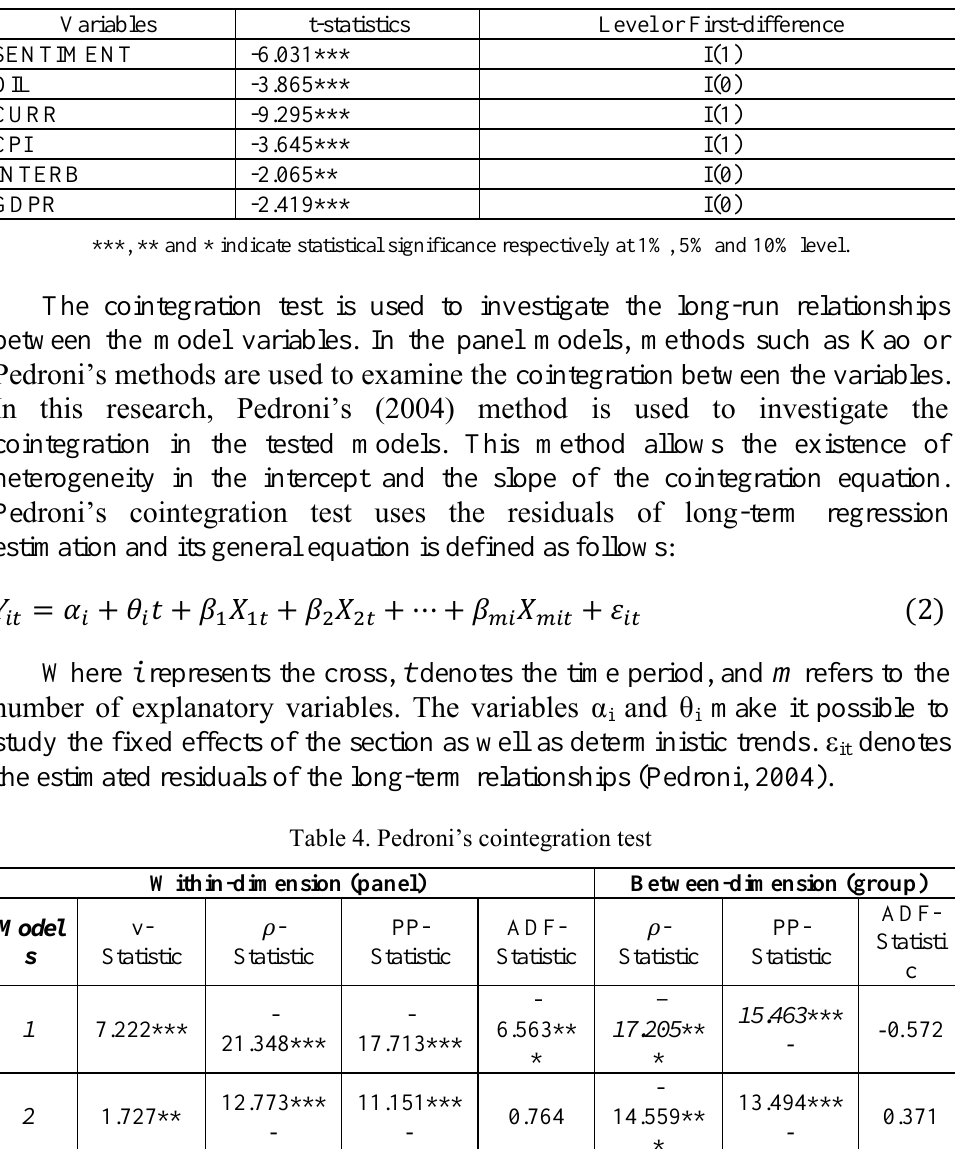
Table 3. Results of the panel stationary test (LLC method)